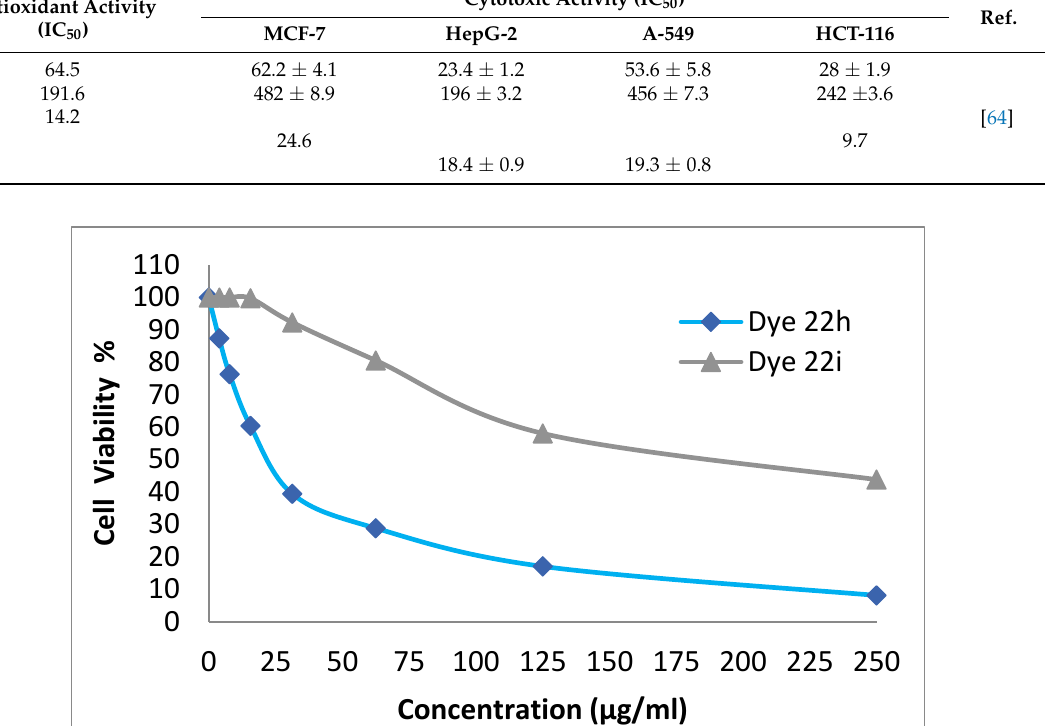
Table 4. Antitumor and antioxidant activities of disperse dyes 22h and 22i.